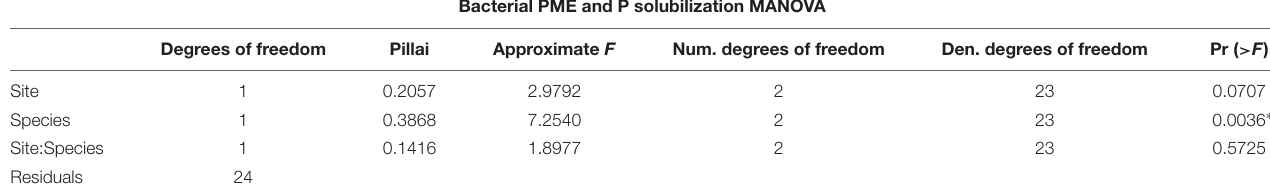
TABLE 5 | Two-way repeated measures MANOVA of bacterial PME and P solubilization activity. Bacterial PME and P solubilization